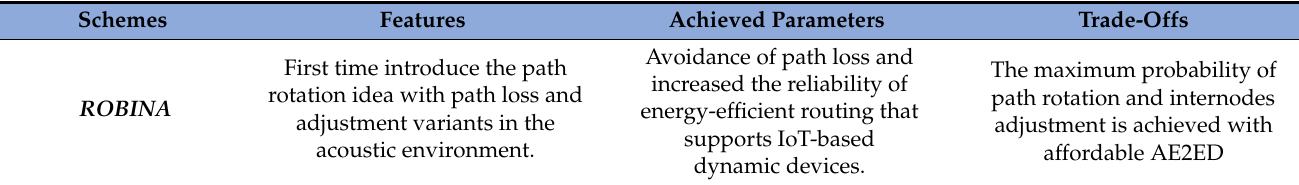
Table 3. Overall performance